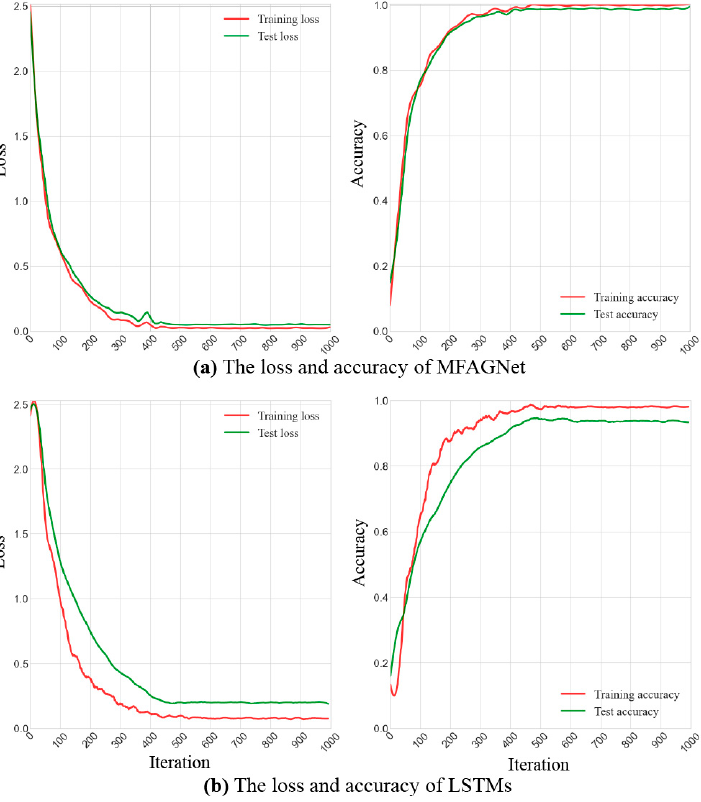
Figure 8. The loss and accuracy by using combination A during the training process: ( a ) MFAGNet, ( b ) LSTMs.